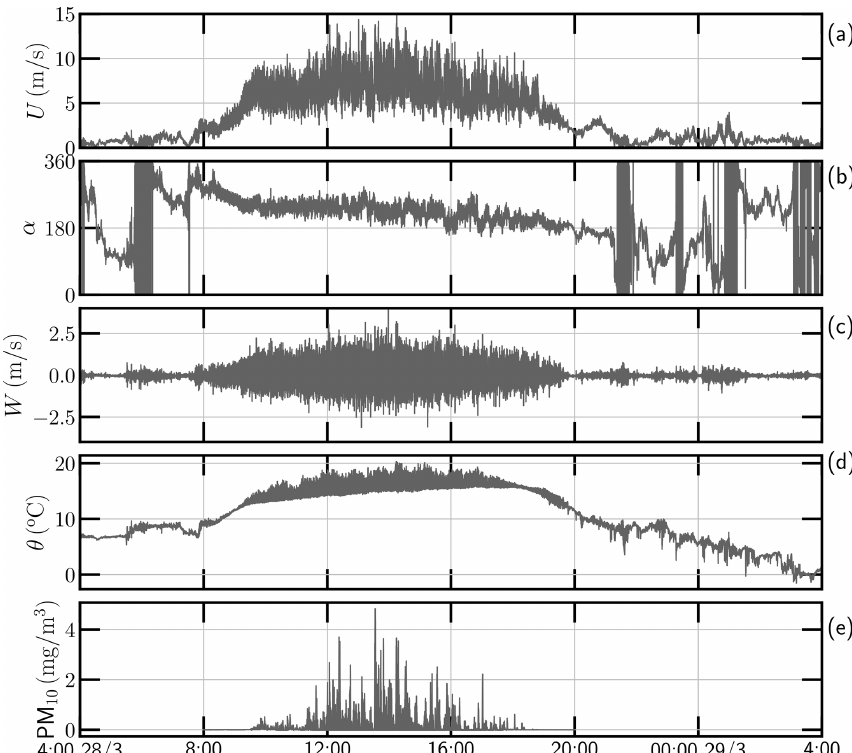
Figure 2. The measured parameters during the dust storm from 04:00 on 28 March 2016 to 04:00 on 29 March 2016: (a, c) horizontal wind speed (ms − 1 ) and vertical wind speed (ms − 1 ), (b) wind direction ( α = 0 corresponding to the northwestern direction; positive when the wind direction varied in the clockwise direction), and (d, e) temperature ( ◦ C) and PM 10 concentration (mgm − 3 ). Note that data are from the height z = 3 . 49m.